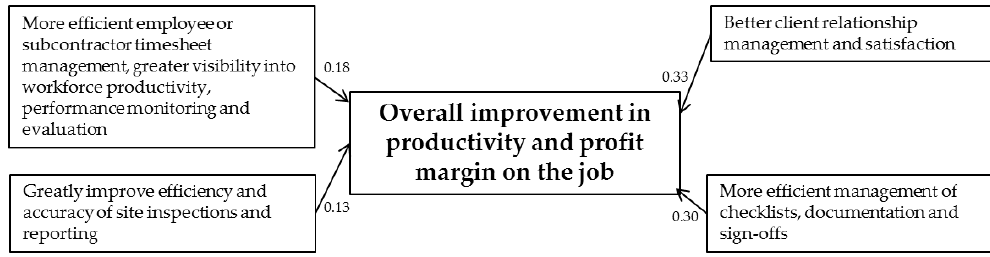
Figure 2. SEM of the Causal Relationships Between the Perceived Benefits of Apps and Overall Productivity Improvement